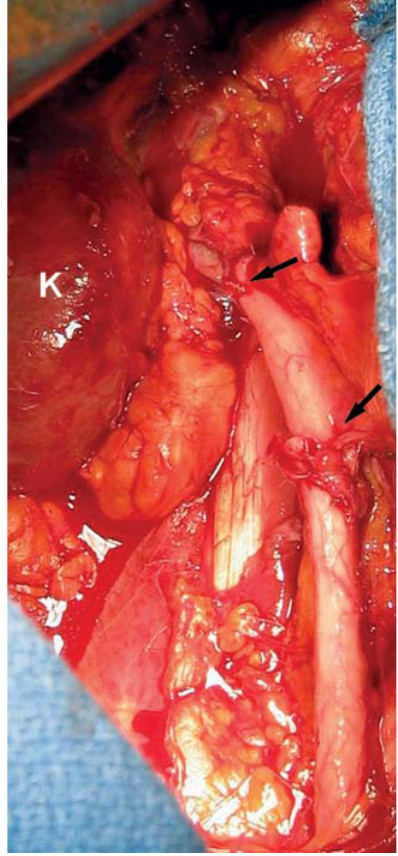
Figure 2 – Completed appendiceal interposition (arrows). K = right kidney.